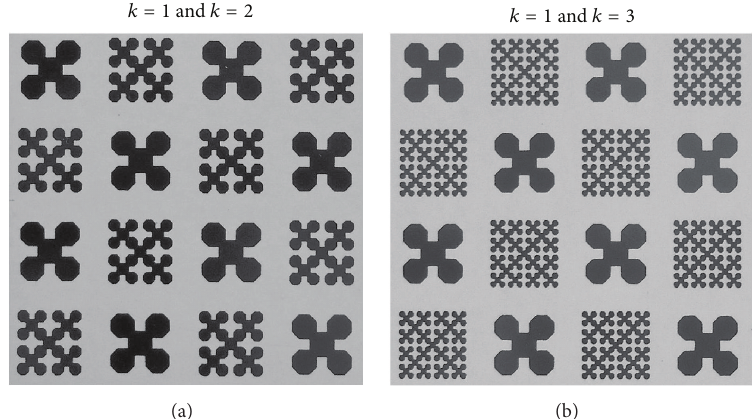
Figure 3: Photographs of two FSS prototypes composed of dissimilar Sierpinski patch elements with (a) 𝑘 = 1 and 𝑘 = 2 and (b) 𝑘 = 1 and 𝑘 = 3 fractal level motifs.